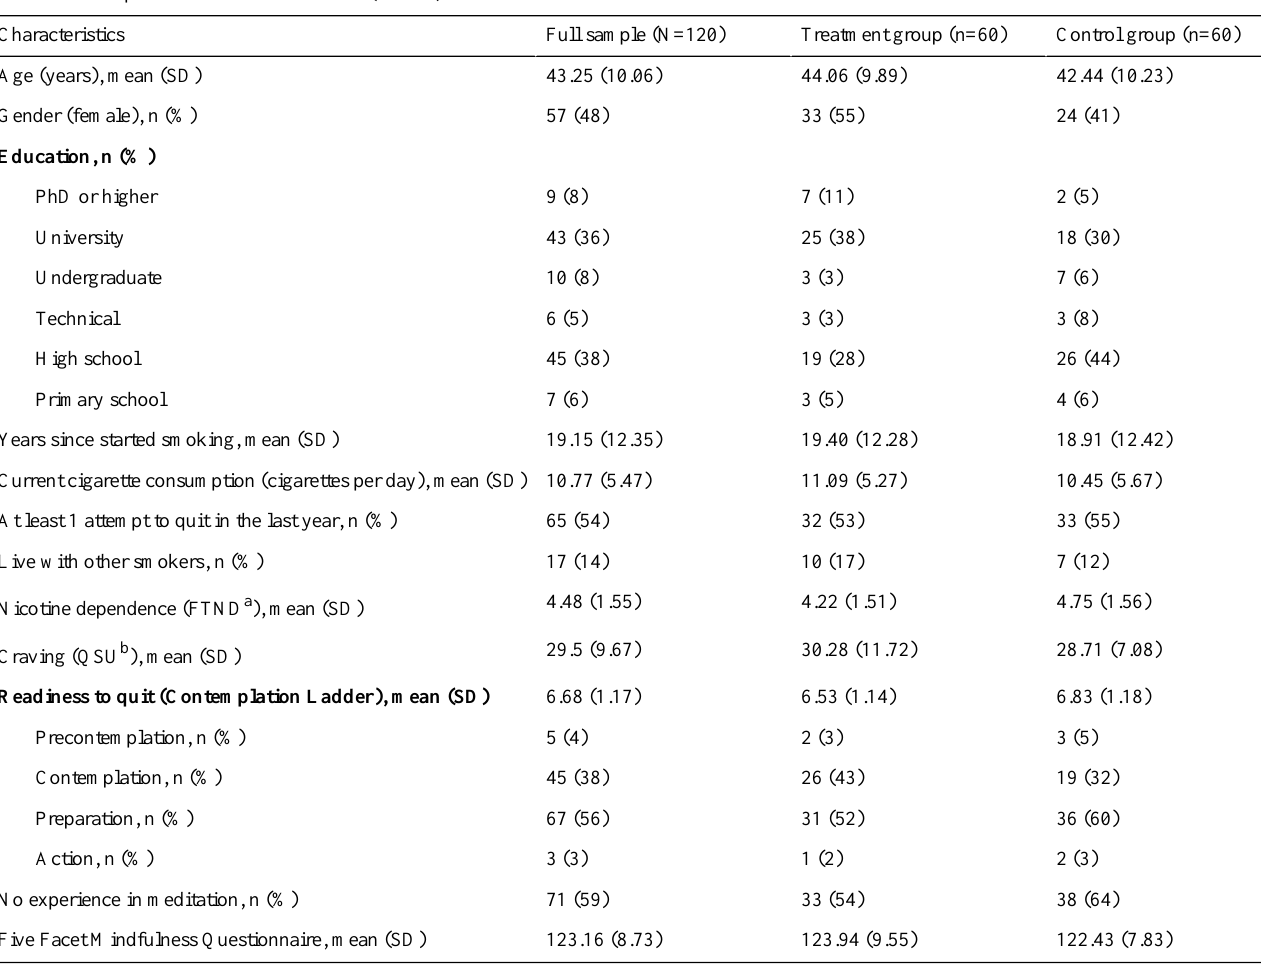
Table 1. Participant baseline characteristics